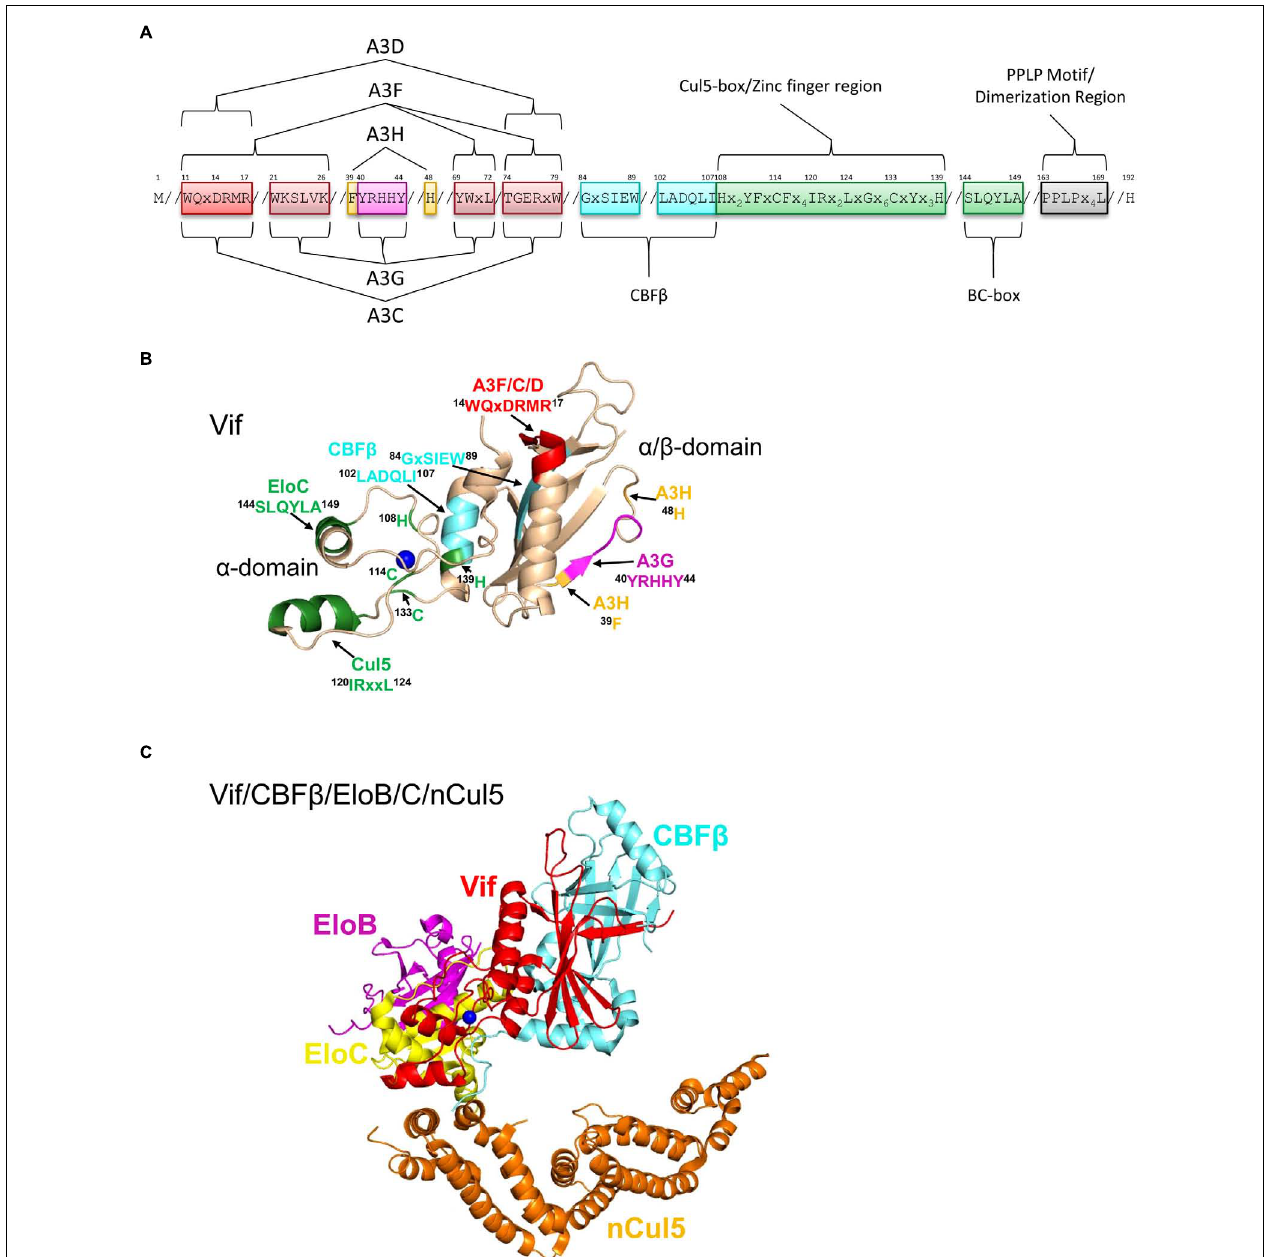
FIGURE 5 | Structure of Vif and host interacting partners. (A) Domain organization of Vif. Vif uses specific motifs to interact with A3G (magenta, 40 YRHHY 44 ), A3F/A3C/A3D (red, 11 WQxDRMR 17 and 74 TGERxW 79 ), and A3H (orange, 39 F and 48 H). In conjunction with these specific motifs, there are shared interaction motifs for A3F and A3G with Vif (pink, 21 WKSLVK 26 and 69 YWxL 72 ). CBF β interacts with Vif through two adjacent motifs (cyan, 84 GxSIEW 89 and 102 LADQLI 107 ). The Zinc finger region (green, amino acids 108-139) coordinates the Zinc through an 108 H 114 C 133 C 139 H motif and stabilizes the Vif structure, which indirectly enables an interaction with Cullin 5 (Cul5). Direct interaction of Vif with Cul5 is through amino acids 120 IRxxL 124 . The BC box mediates an interaction with Elongin C (green 144 SLQYLA 149 ). Vif oligomerizes through a PPLP motif (gray, 163 PPLPx 169 ). Slanted lines are used to indicate intervening amino acids 4 L between the domains. (B) The crystal structure of Vif (PDB: 4N9F) shows